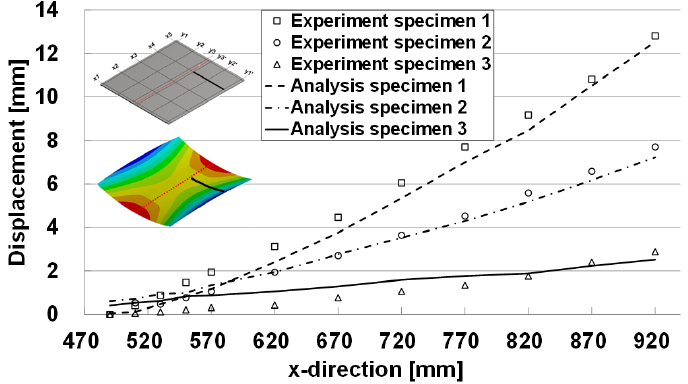
Figure 13. Butt welding analysis and experimental results (line x4).